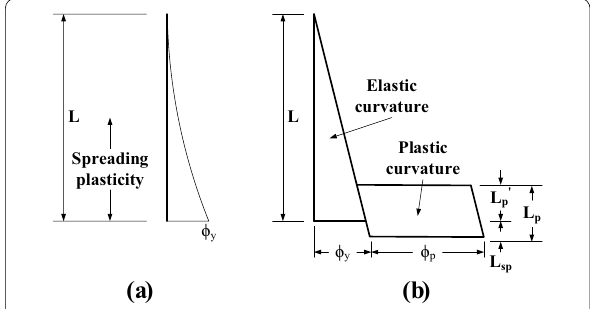
Fig. 3 Plastic hinge concept: a actual curvature distribution and b approximated curvature distribution (Fedak, 2012).